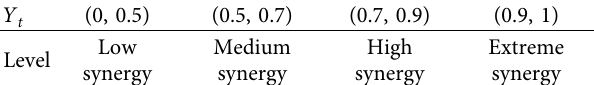
Table 2: Criteria for grading the synergy between port logistics and regional economy.